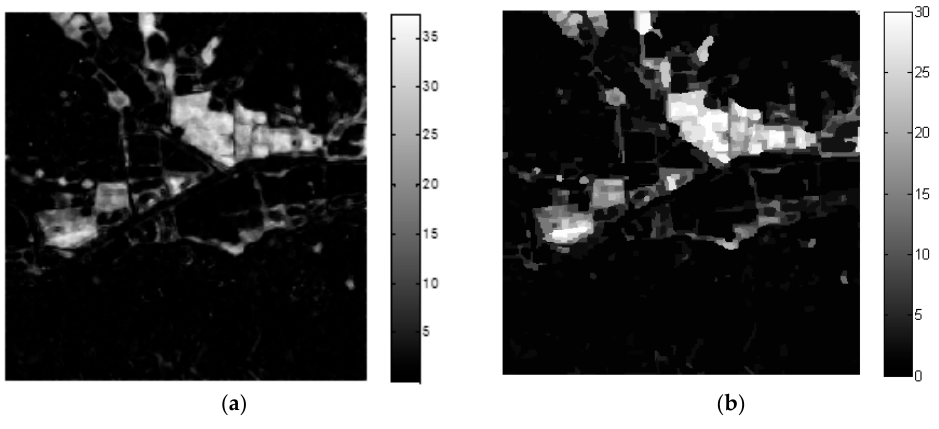
Figure 8. ( a ) The DI based on pixels; ( b ) The result of GSRM.